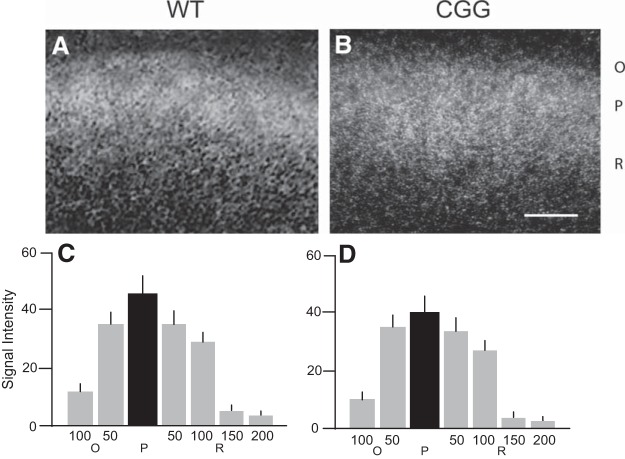
Somato-dendritic distribution of MAP2 mRNA in WT and CGG brains. A, B, MAP2 mRNA distribution in hippocampal CA1 of WT and CGG animals. CA1 strata oriens (O), pyramidale (P), radiatum (R) are indicated. Scale bars, 100 μm. C, D, Quantitative analysis: one-way ANOVA, p = 0.94065. Comparison of signal intensities (given in relative units) in stratum P (center), in stratum O at distances of 50 and 100 μm from edge of stratum P, and in stratum R at distances of 50, 100, 150, and 200 μm from edge of stratum P, between WT and CGG animals: p > 0.05 for all sample points. n = 4 for WT and GCC animals.